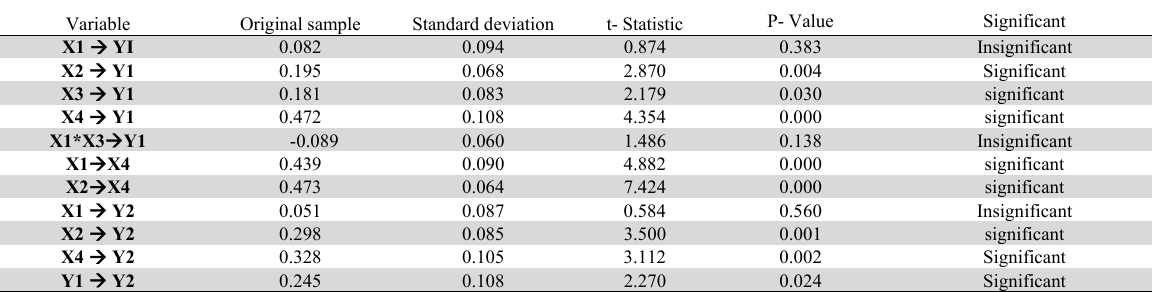
Path Coefficient or Variable Direct Effect Variable Original sample